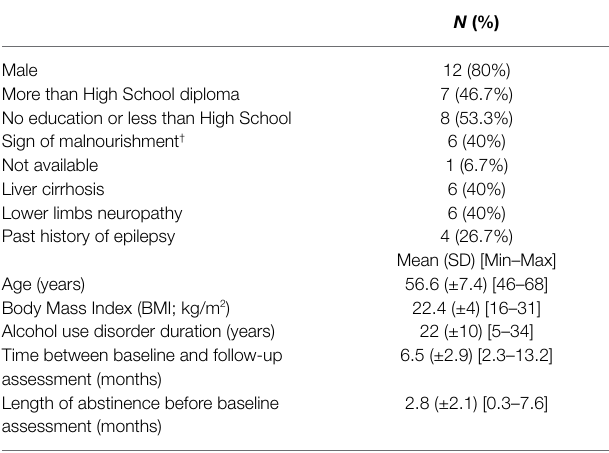
TABLE 1 | Sociodemographic and clinical characteristics of the patients in the severe alcohol-related cognitive impairment group ( N = 15) [Number (percentage) or mean (SD;